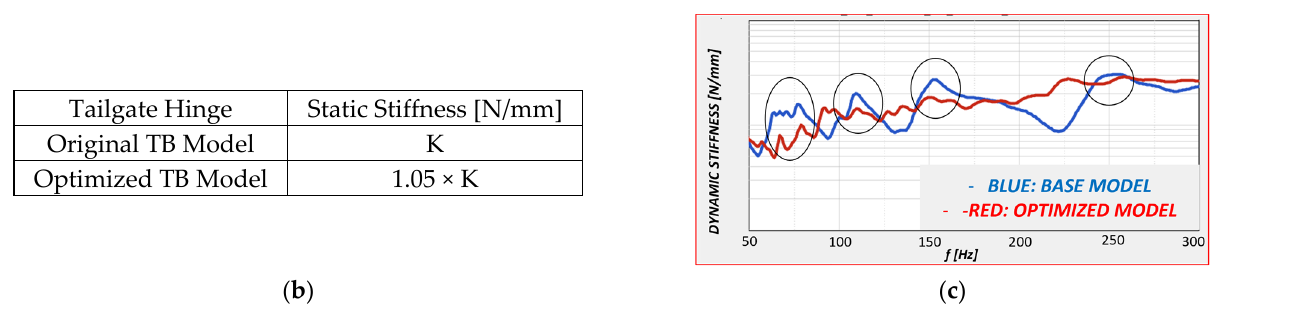
Figure 22. Force application point ( a ), static ( b ), and dynamic ( c ) stiffness of the tailgate hinge, with highlight of frequency ranges where the stiffness of the optimized model is lower than original one.